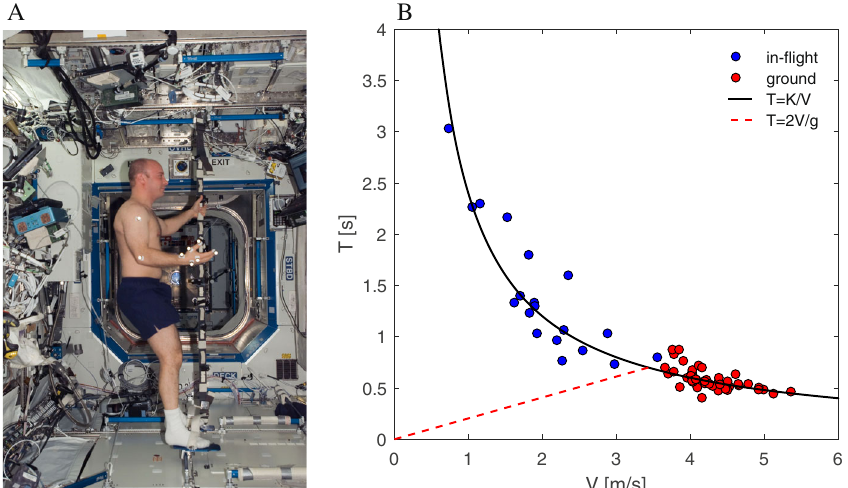
Fig. 1 Setup. A Picture of astronaut Garrett Reisman on the ISS, performing the protocol of throwing the imaginary ball to the ceiling and catching it on the rebound. Written informed consent for the publication of the picture was obtained from Garrett Reisman. Image courtesy of NASA. B Throws of a real ball on ground (red) and in- fl ight (blue). Black continuous and red dashed curves correspond to T = K/V and T = 2 V/g , respectively. K = 2.4 m (mean path length of ball trajectory, see